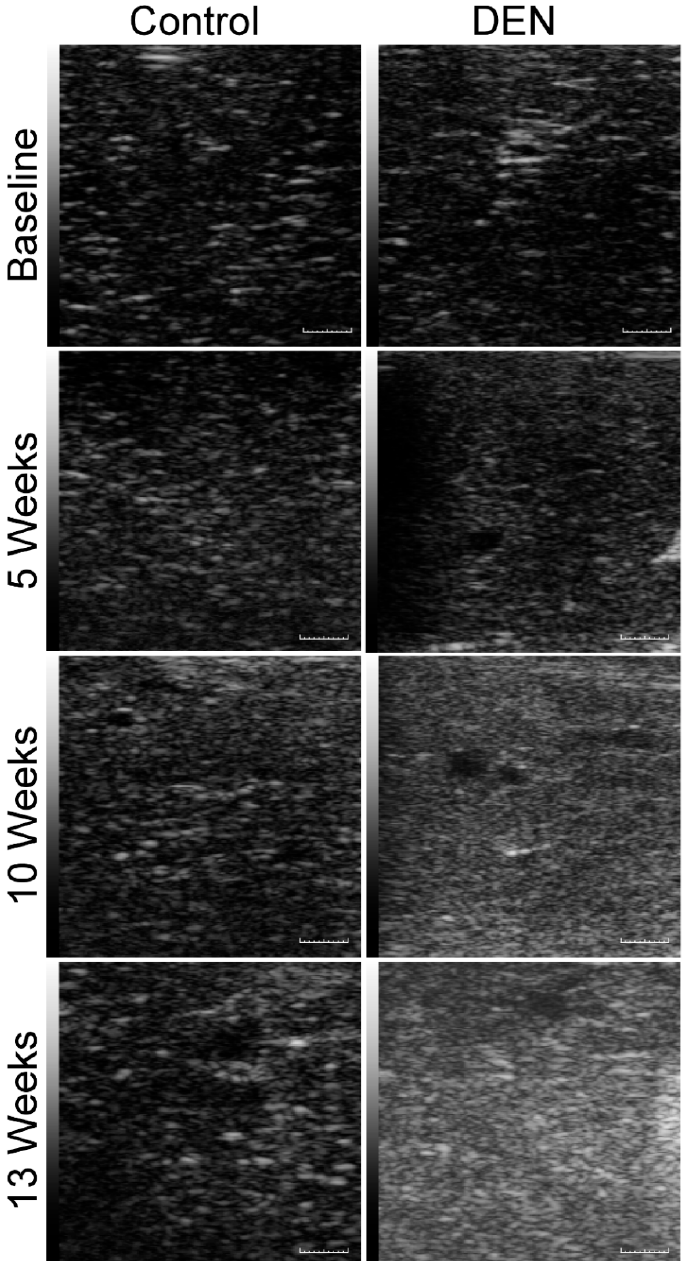
Figure 3. Qualitative assessment of echogenicity of sagittal B-mode ultrasound images. Sagittal B-mode sonograms of the middle lobe of rat livers were obtained either prior to the ingestion of DEN (baseline) or 5, 10, and 13 weeks after its administration. Note that as the hepatic fibrosis developed there were statistically significant increases in echogenicity of the liver tissue 10 and 13 weeks after the commencement of DEN administration compared to the control rats. Control rats showed no increase in echogenicity over time and remained comparable to the baseline. Scale bar = 1 mm.